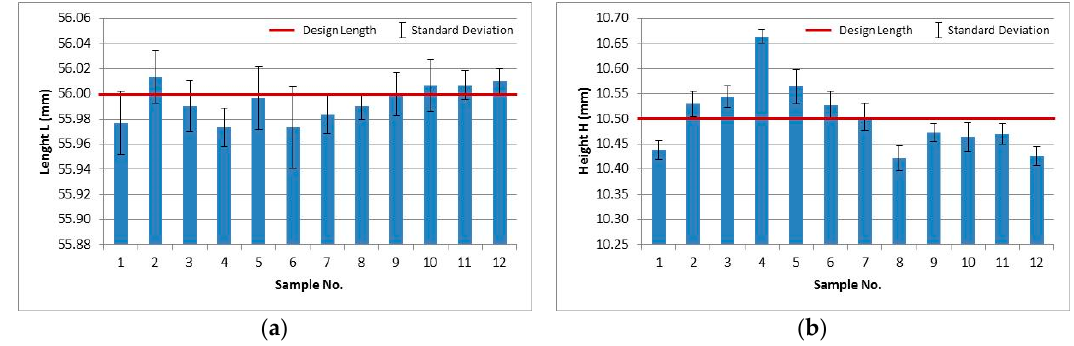
Figure 5. ( a ) Length and ( b ) height variation in developed samples with standard deviation.